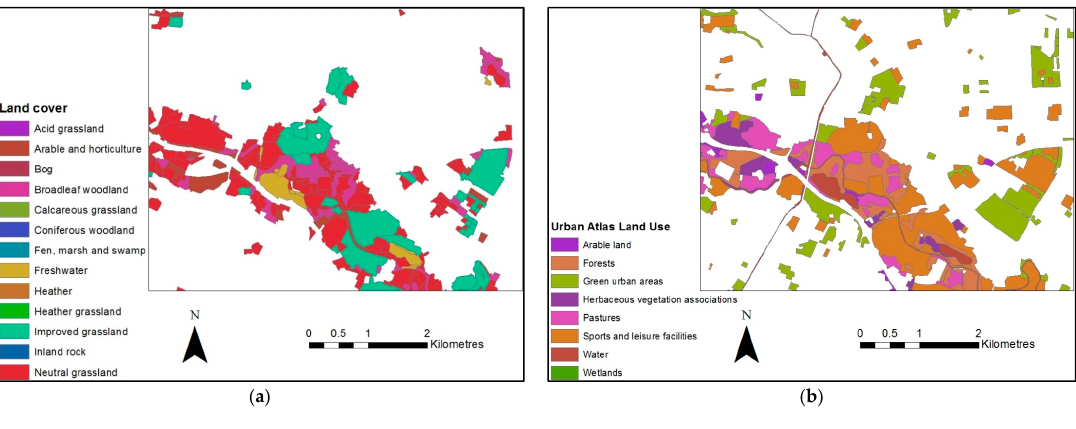
Figure 7. ( a ) (Top left) UK LCM 2015 (Rowland et al., 2017); ( b ) (top right) Urban Atlas 2012 (EEA, 2012); ( c ) (centre left) OS Mastermap Greenspace: land use (Ordnance Figure 7. Survey, 2017); ( d ) (centre right) OS Mastermap Greenspace: land cover (Ordnance Survey, 2017); ( e ) (bottom left) composite land cover map from stage one of the method and ( f ) aerial photograph (25 cm) of the same area (Edina, 2017).